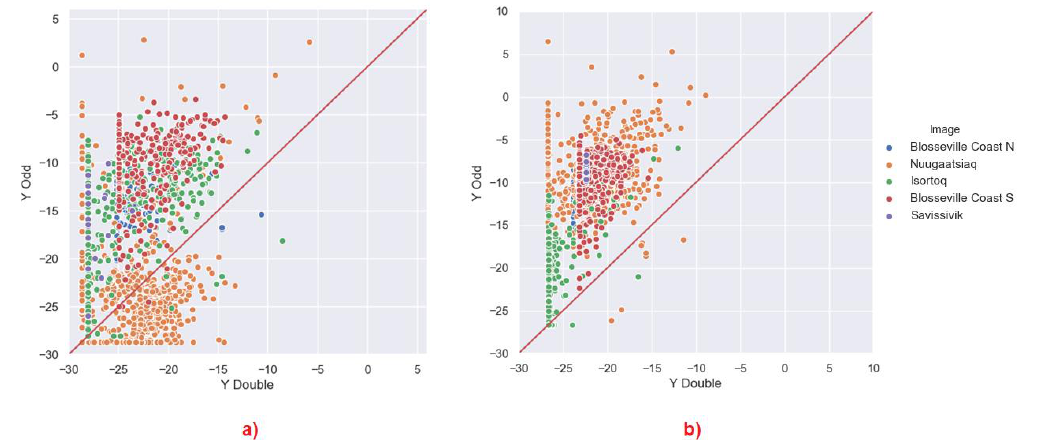
Figure 24. ( a ) Iceberg double bounce scattering, surface scattering plot in a 5 × 5 window, ( b ) 11 × 11 window. The majority of icebergs show volume scattering. Colour legend indicates image. Dots indicate icebergs. All values are in dB.